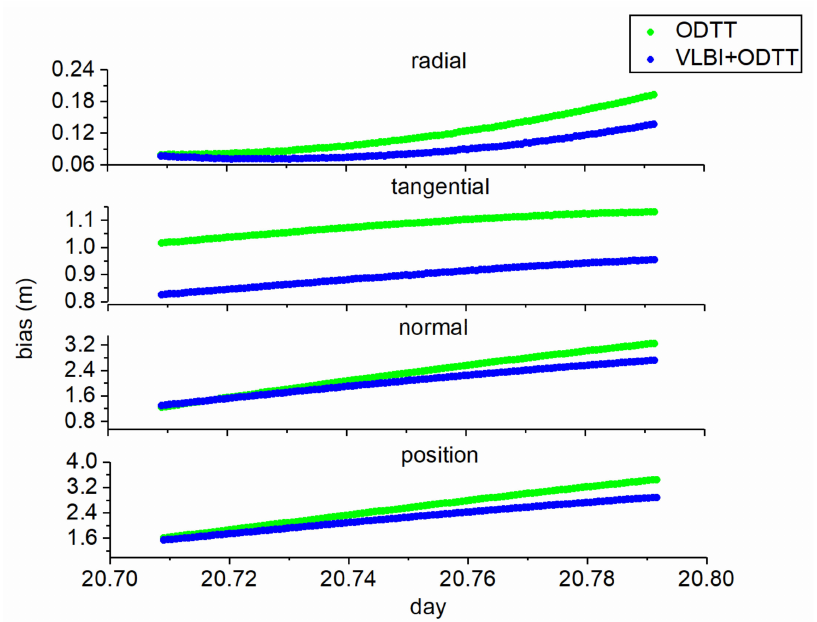
Figure 8. The bias during the period of 20 August 17:00–20 August 19:00.